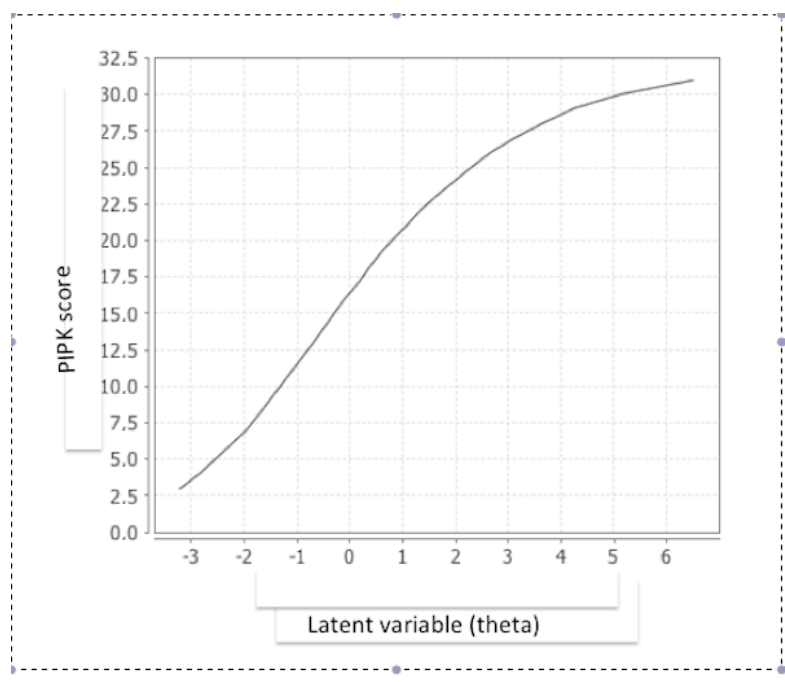
Figure 2. Graphic of the direct score of the PIPK questionnaire (Y axis) versus the true score of the latent variable measured (theta) (X axis).